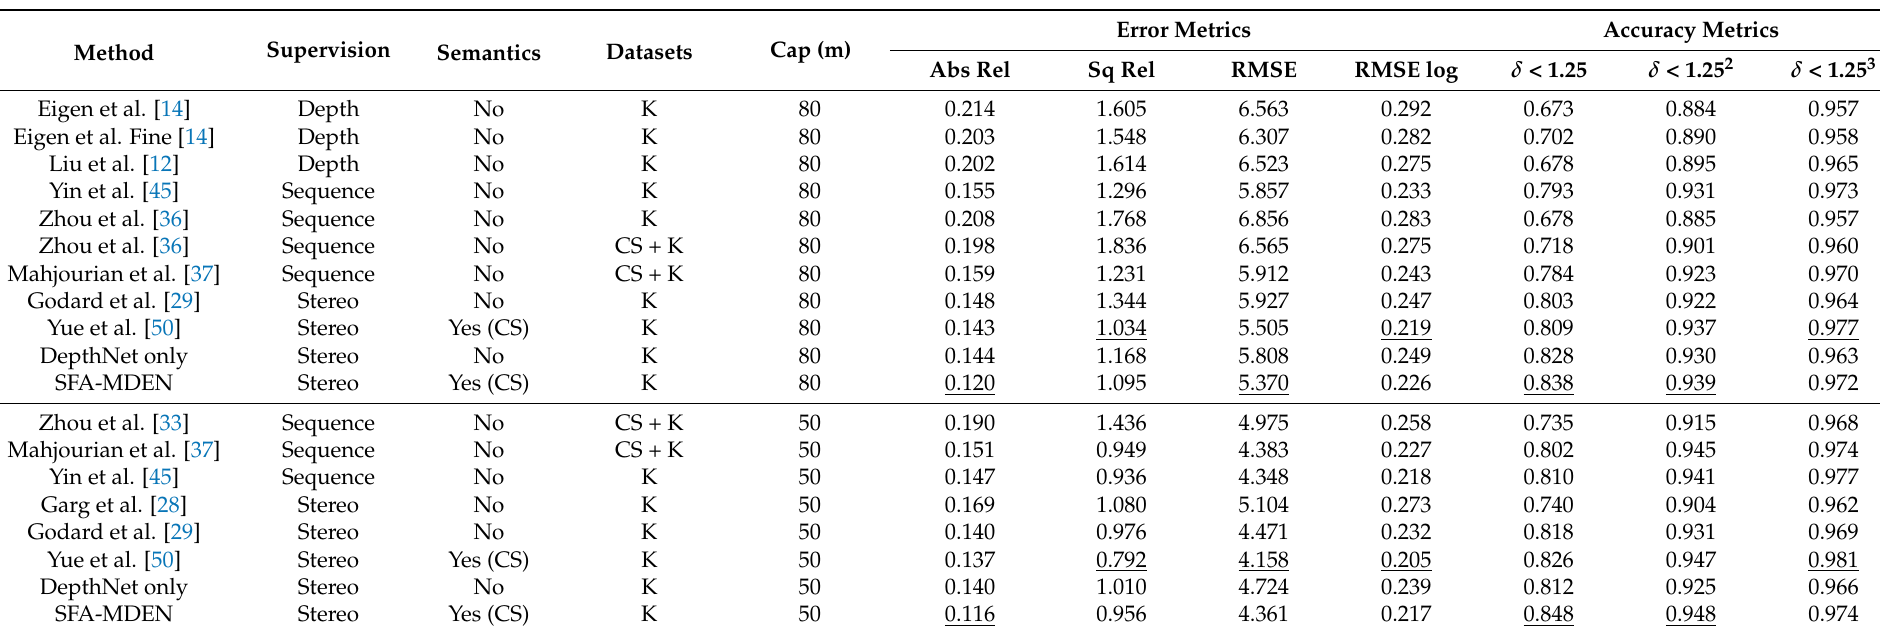
Table 1. Monocular depth estimation evaluation using the split of Eigen et al. [14] on the KITTI dataset [9]. For datasets, K = KITTI, and CS = Cityscapes, CS + K means that the model is pretrained on the Cityscapes and finetuned on the KITTI. For methods with semantics, the dataset for semantic segmentation training is in brackets. We highlight the best results with the underline in each depth cap. The results of Garg et al. [28] are only capped at 50